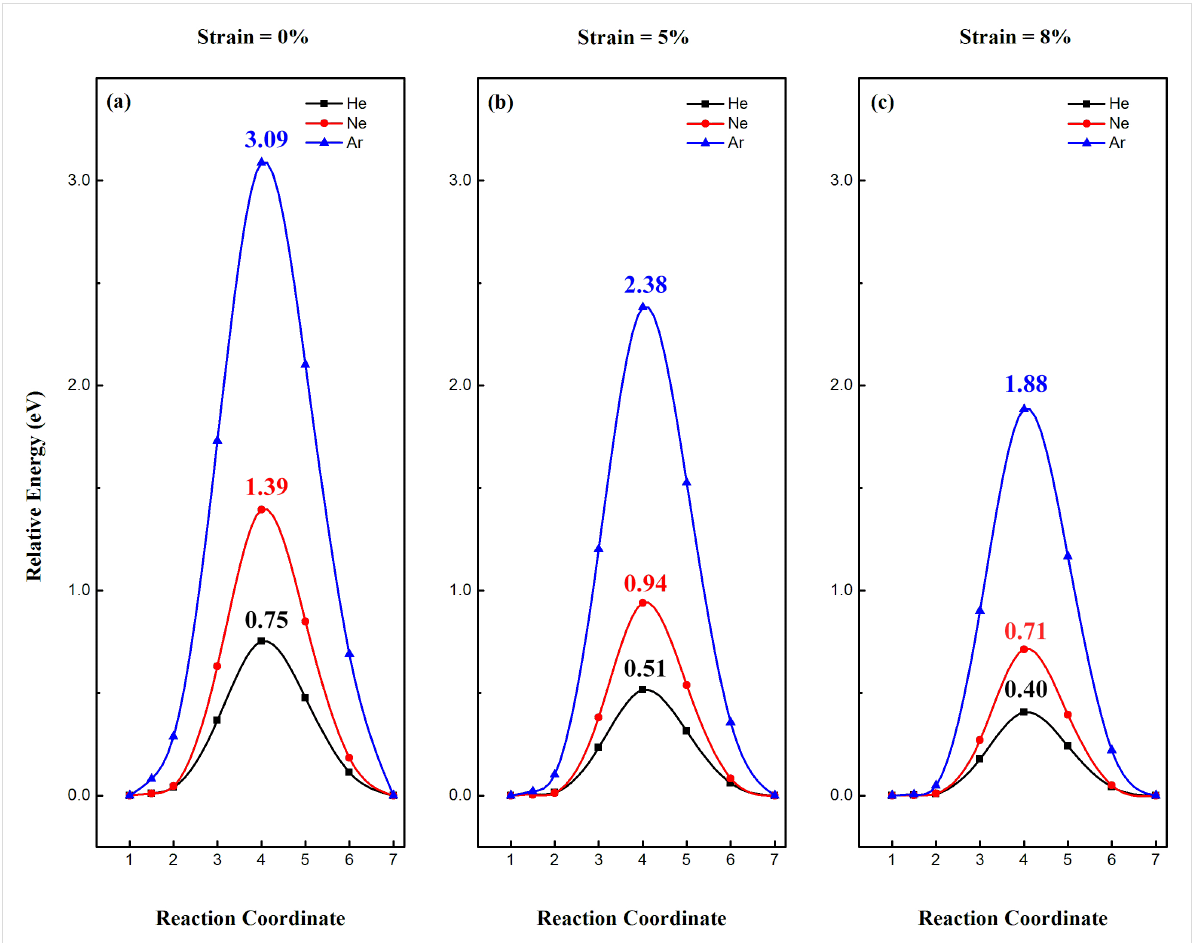
Figure 2: Minimum pathway for noble gases (He, Ne and Ar) penetrating through 2D Sn lattice under (a) 0%, (b) 5% and (c) 8% strain.